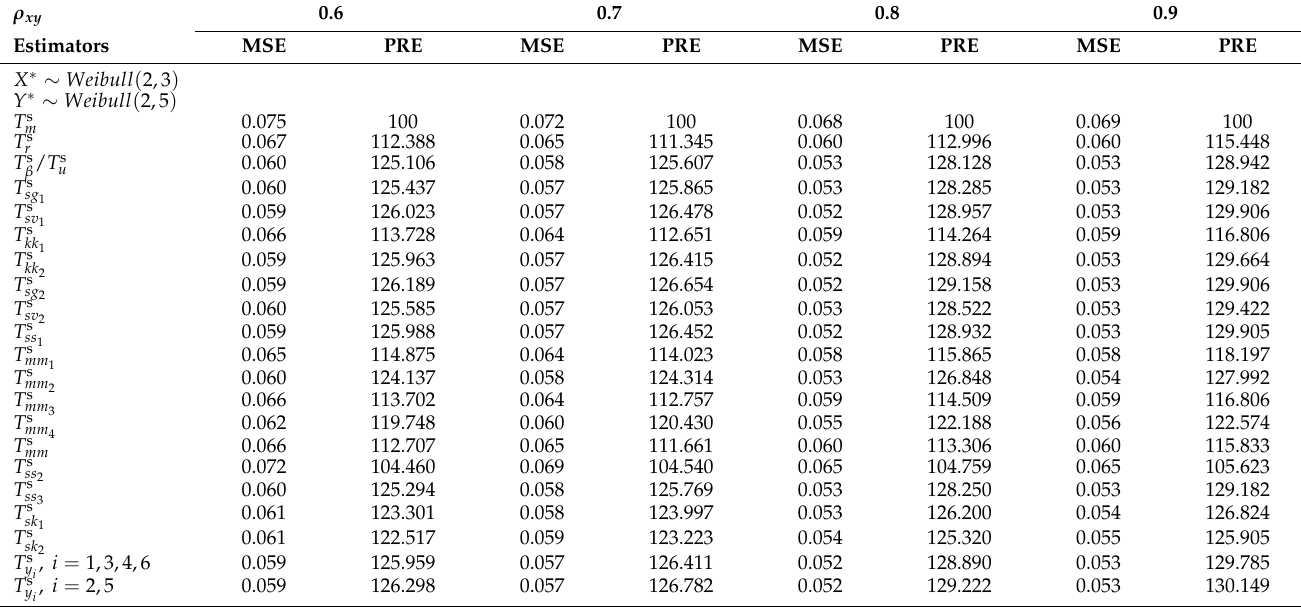
Table 8. MSE and PRE of separate estimators utilizing hypothetically drawn Weibull